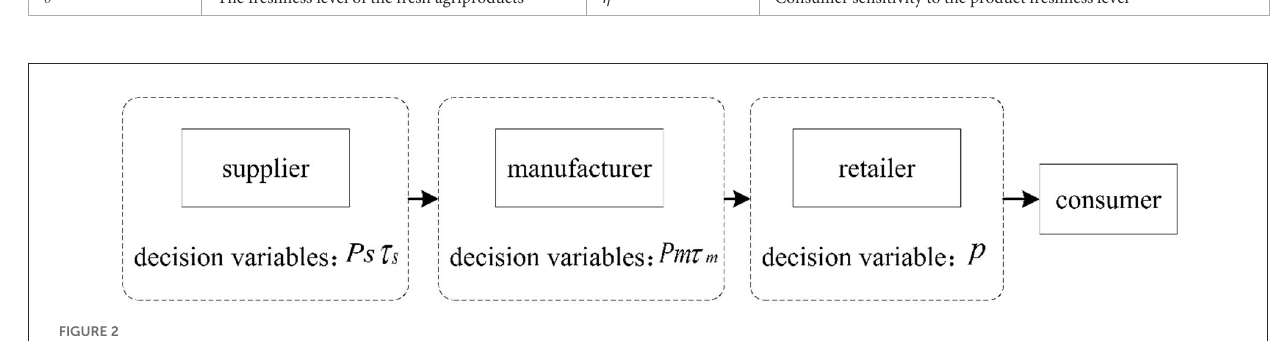
FIGURE2 Supply chain model under the scenario